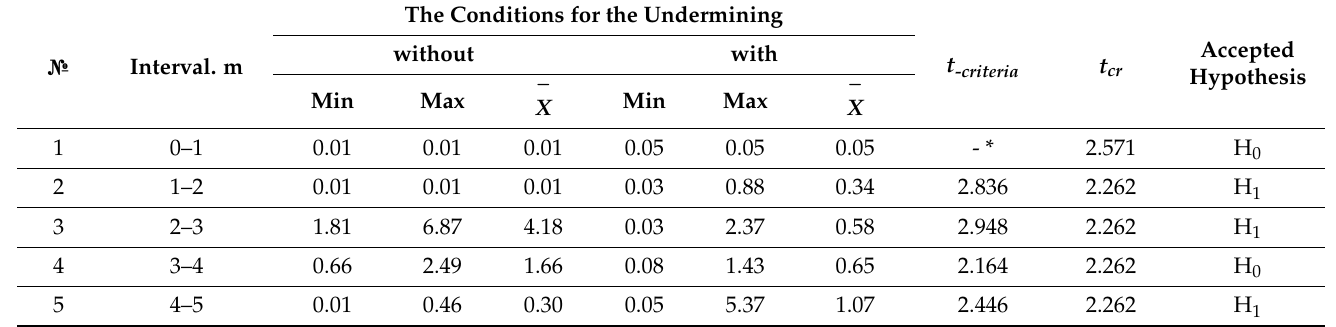
Table 8. The results of the statistical analysis of the experimental studies of the starting gas release of the camera